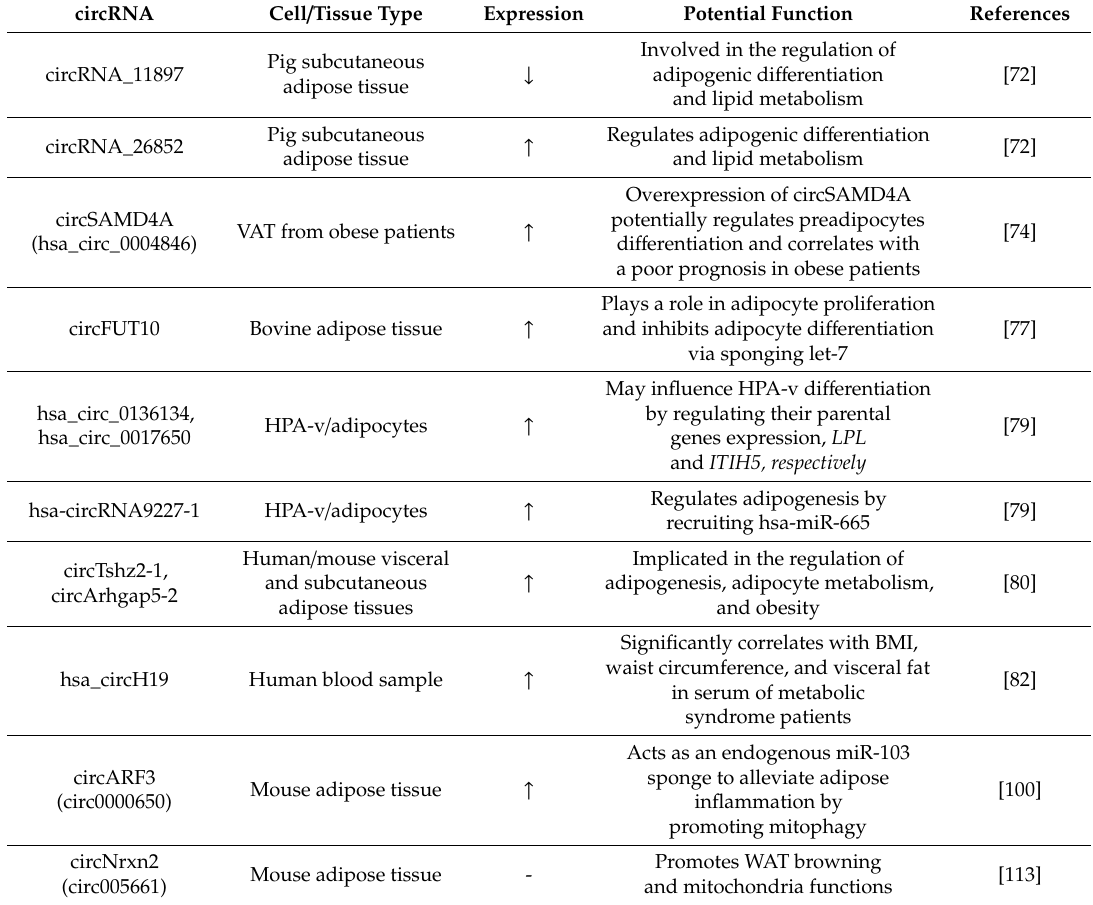
Table 1. Relevant circular RNAs involved in adipogenesis and obesity-related metabolic